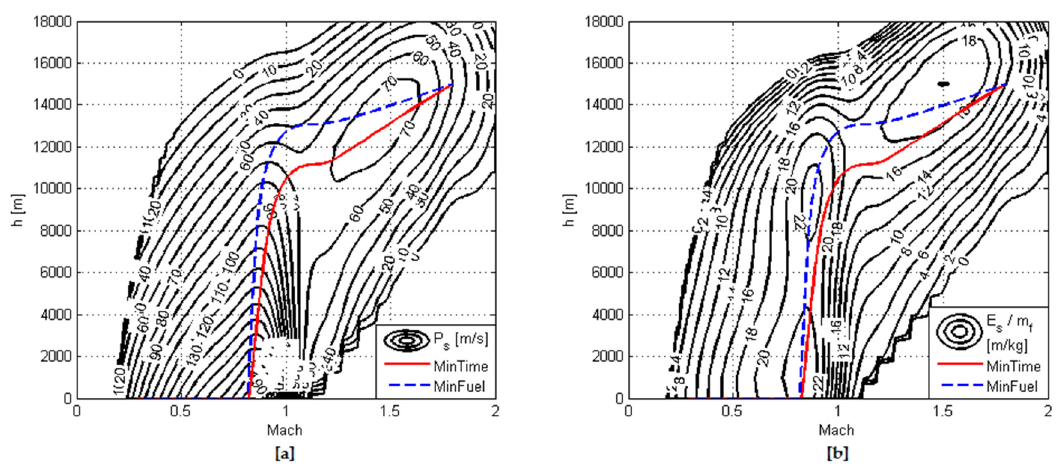
Figure 19. Case B, Configuration C3; Minimum Time and Minimum Fuel climb paths, plotted over